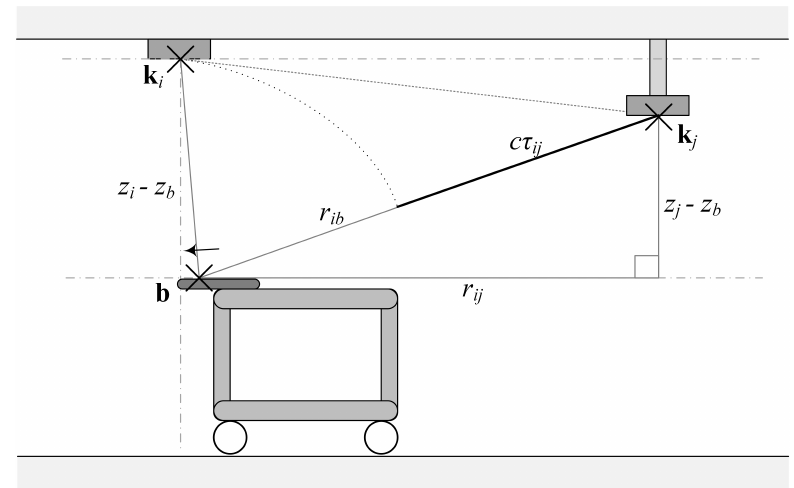
Figure 4. Distance estimation set-up, that reduces the degrees of